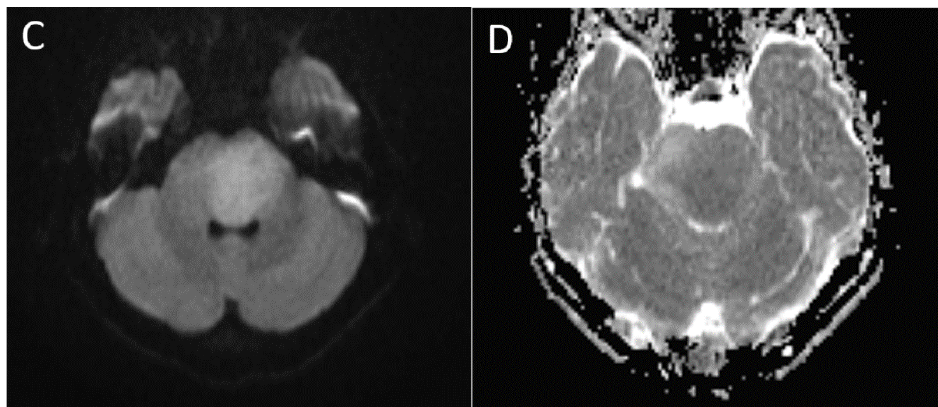
Figure 6. A 5-year-old boy with diffuse midline glioma H3K27-altered. Axial T2 ( A ), post-contrast T1 ( B ) images demonstrate a poorly marginated infiltrative, expansile T2 hyperintense lesion cen- tered in the pons with little to no enhancement. DWI ( C ) and ADC ( D ) images demonstrate hetero- genous signal without significant diffusion